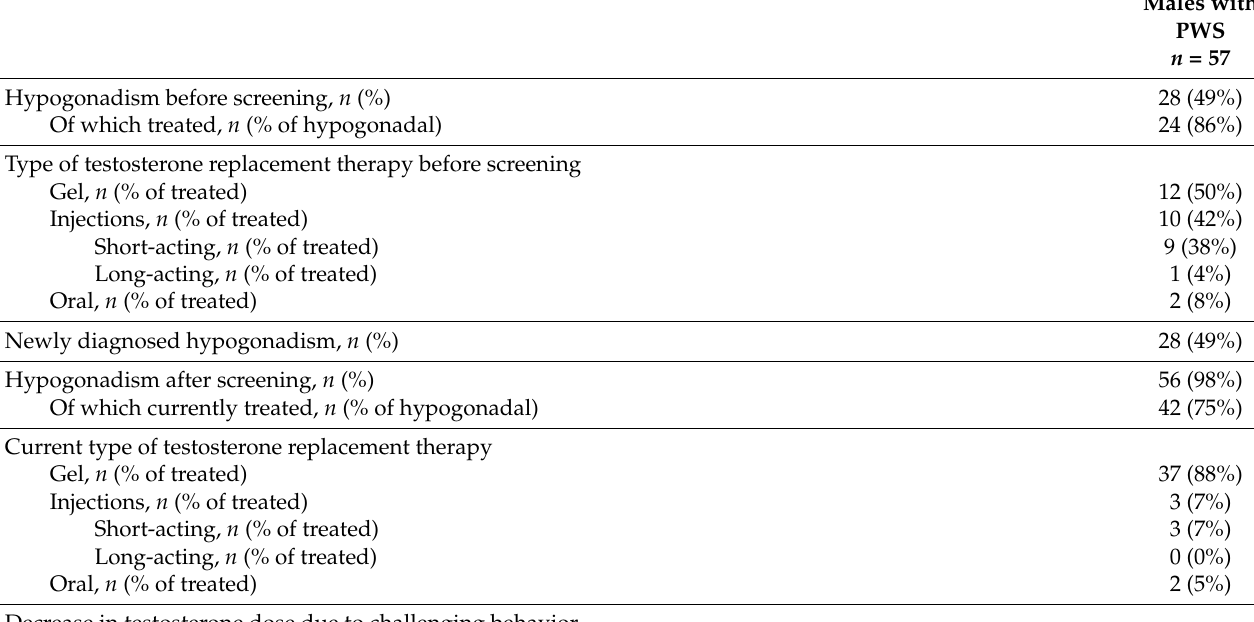
Table 2. Hypogonadism in male adults with